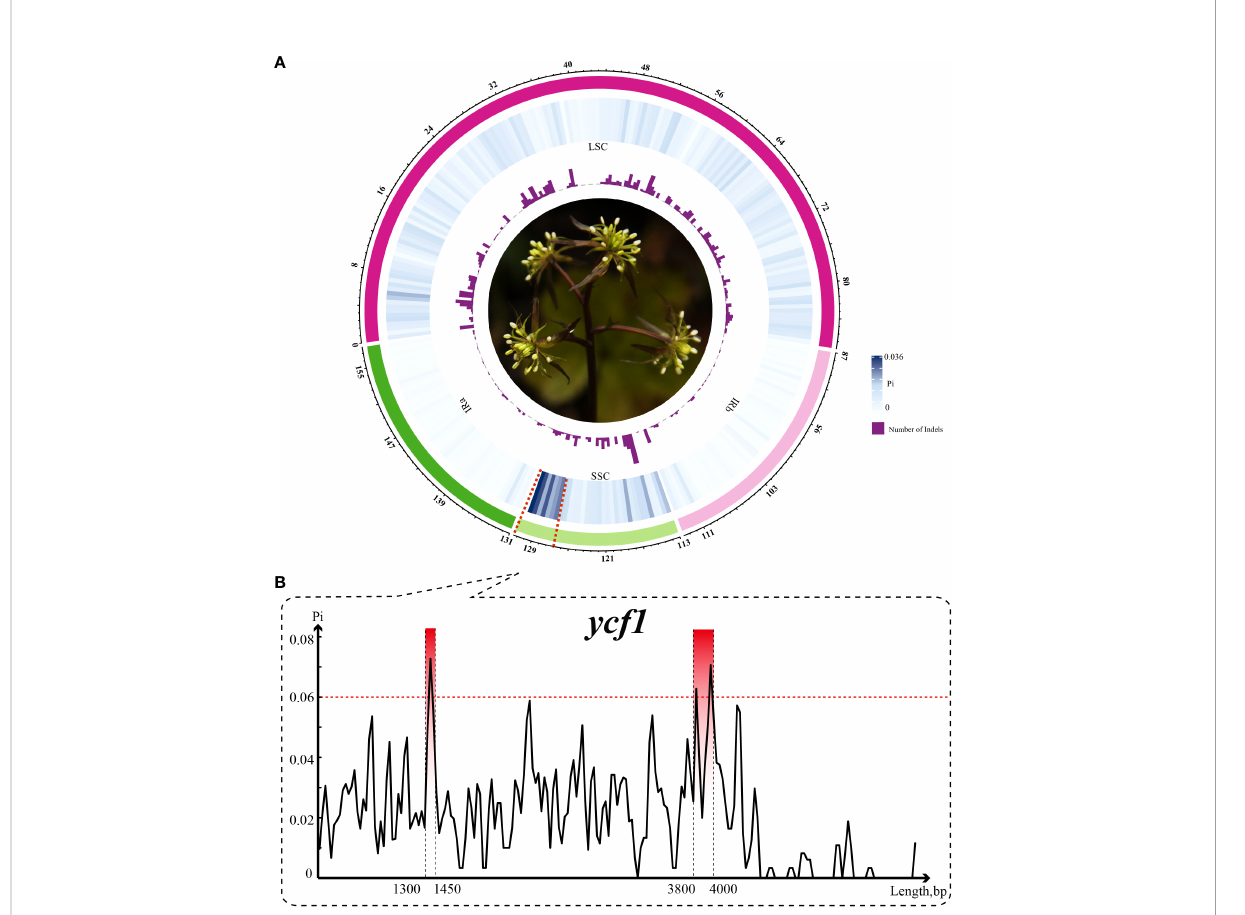
FIGURE 1 Variation of Coptis plastomes. (A) Circos plot showing the indel and nucleotide diversity of Coptis . Circles from the outer to inner area show the following: structure of plastomes indicated by different colors, nucleotide diversity shown by a heatmap and indel count shown by a histogram. Window size of each grid is 500 bp. (B) Sliding-window analysis of the ycf1 gene. The most divergent region (top three region with Pi > 0.06) is